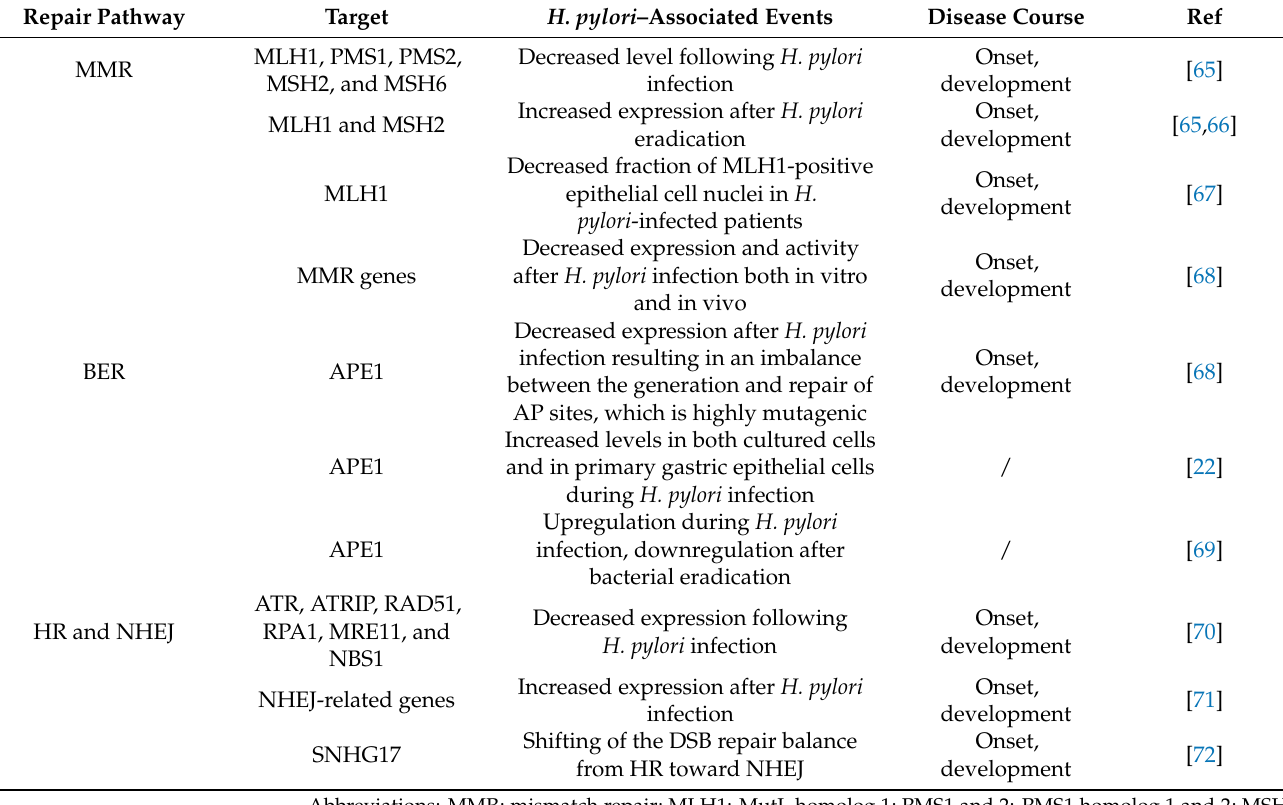
Table 2. Effects of H. pylori infection on DNA repair